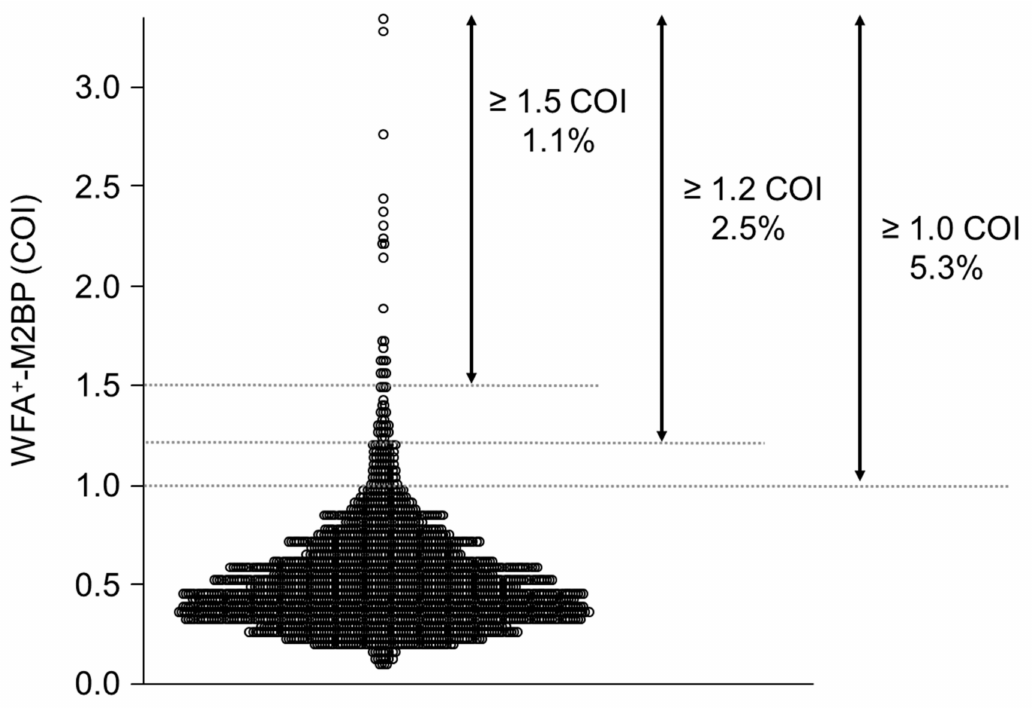
Figure 2. Distribution of WFA +